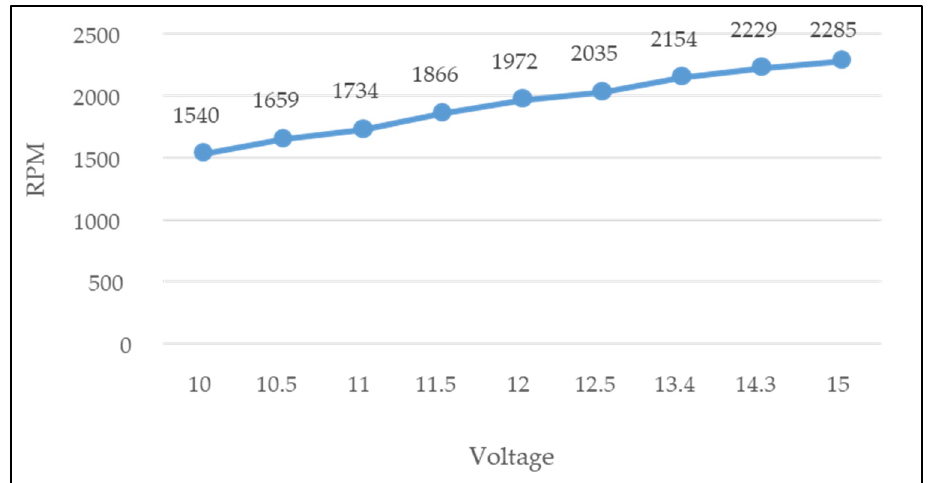
Figure 12. The voltage vs. motor RPM characteristics of the design.